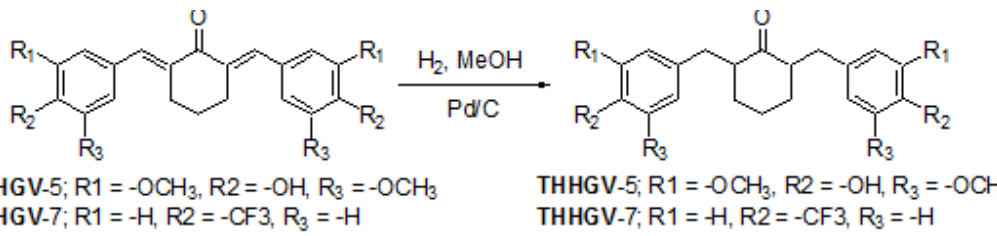
Figure 2. Hydrogenation Reaction of HGV-5 and HGV-7 to be THHGV-5 and